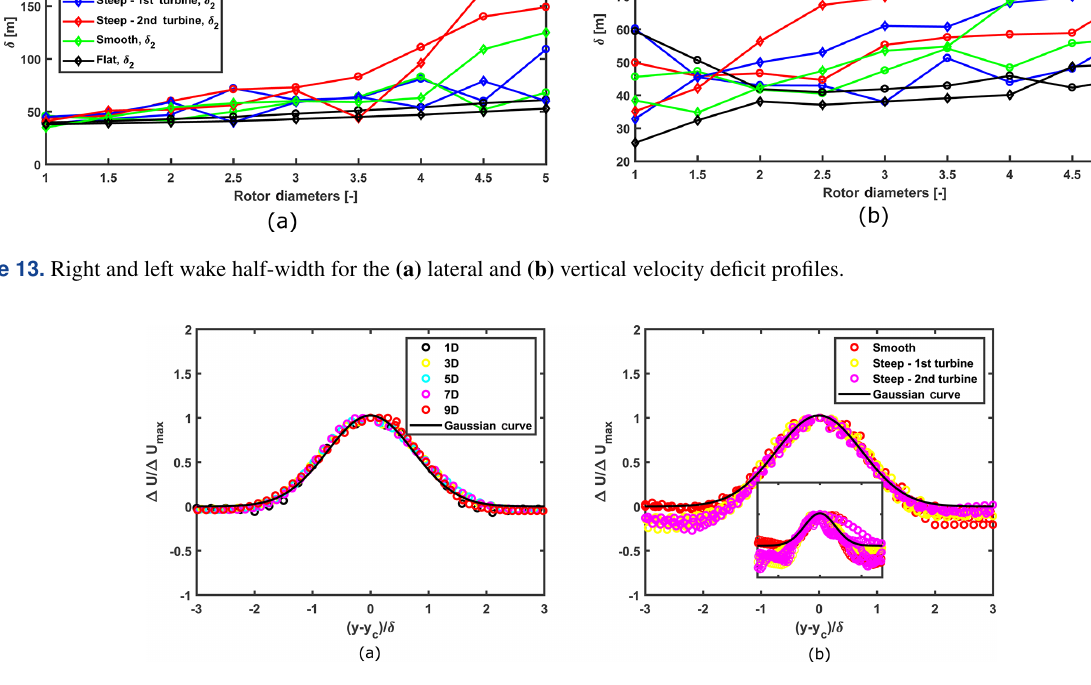
Figure 14. Self-similar lateral profiles of streamwise velocity deficit (a) flat case (b) complex cases for a downstream distance of 1D to 3D with intervals of 0.5D; inset shows normalized velocity deficit profiles from 3.5D to 5D.